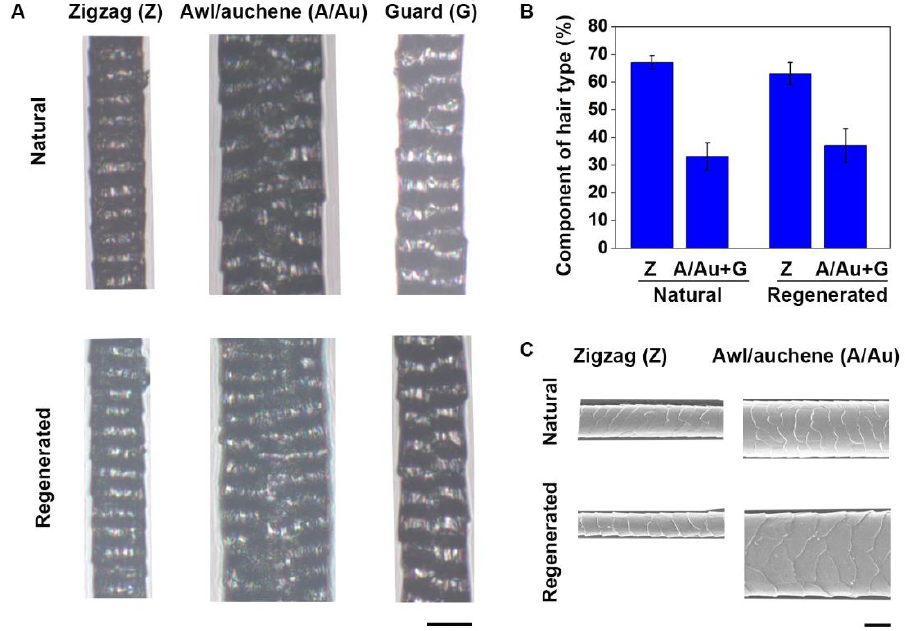
Figure 7. Analysis of the hairs regenerated by ESS. ESS consisting of cultured mouse SKPs and neonatal mouse epidermal cells in C-GAG were transplanted into excisional wounds in nude mice. The hairs regenerated from the grafts were analyzed 21 days after transplantation, and were compared with natural hairs collected from the back of wild type mice. ( A ) Microscopic observation showed that the regenerated hairs included zigzag (Z), awl/auchene (A/Au), and guard (G) hairs, similar to natural mouse hairs. Scale bar, 25 μm. ( B ) The amount of different types of regenerated hairs were counted and compared to that of natural mouse hairs. Hairs from six grafts were analyzed, and 100 hairs per graft were examined. ( C ) The hair shafts were analyzed under SEM. Scale bar, 25 μm.